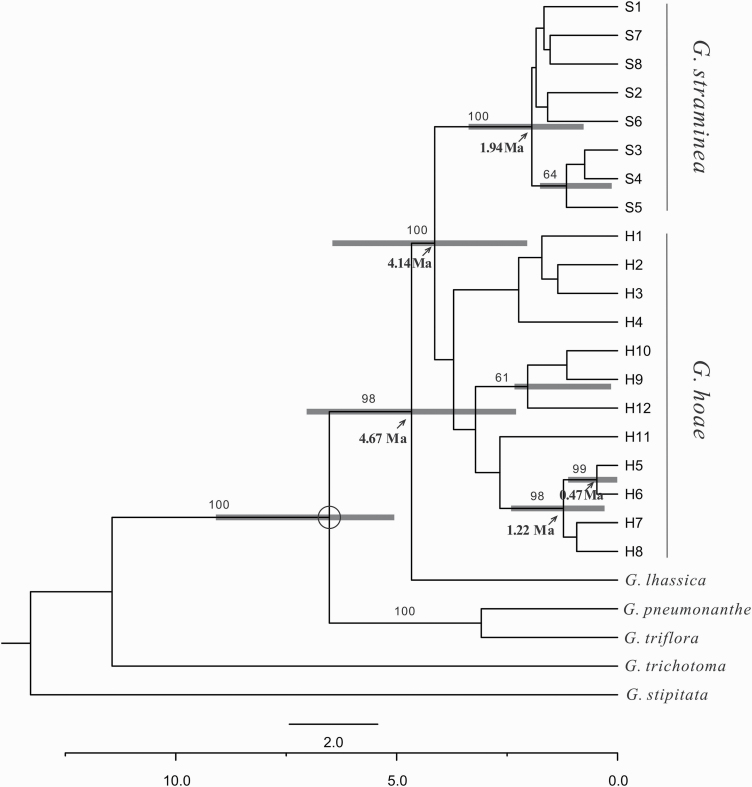
Majority rule consensus phylogenetic tree and divergence times based on Gentiana hoae sp. nov. and closely related species, based on the BI. The tree is based on an alignment of the internal transcribed spacer region. Fossil seeds of Gentiana were used for setting temporal constraints and indicated by a circle around the calibration node. Numbers on the branches indicate the Bayesian PP (only values >70 % are indicated). Node ages represent mean ages (Ma) and bars show the 95 % HPD.